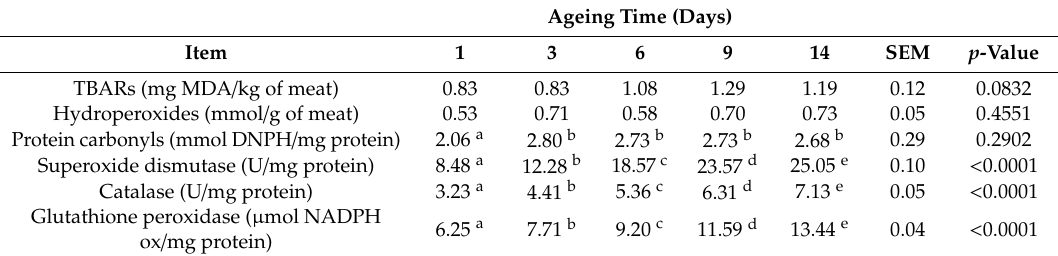
Table 5. E ff ect of aging time on Thiobarbituric Acid Reactive Substances (TBARs), hydroperoxides, protein carbonyls, superoxide dismutase, catalase, and glutathione peroxidase of donkey meat steaks aged for 14 days under vacuum conditions ( n = 10 samples for each aging time).